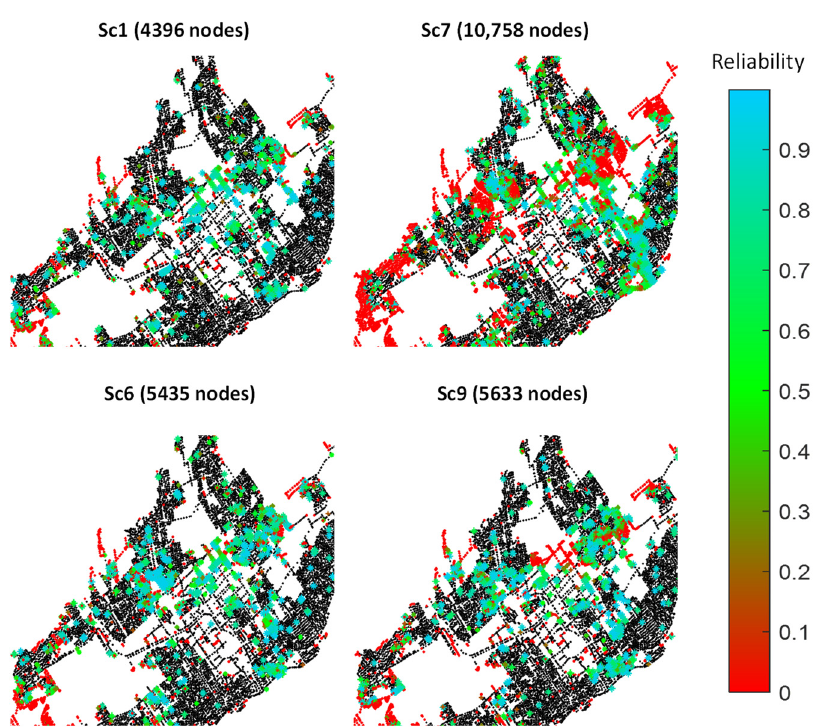
Figure 4. Spatial distribution of nodal chlorine reliability with a value of less than one in Sc1, Sc6, Sc7, and Sc9. Reliability values are represented by both color and size (a function of its value).